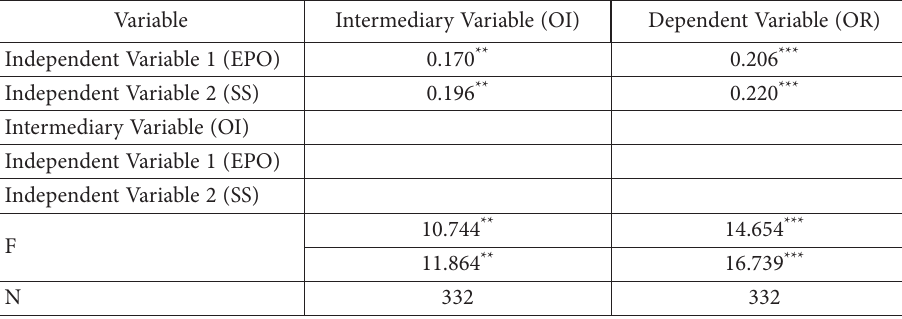
Table 5. Path of mediating effect (source: authors’ illustration) Variable Intermediary Variable (OI) Dependent Variable (OR) Independent Variable 1 (EPO) 0.170